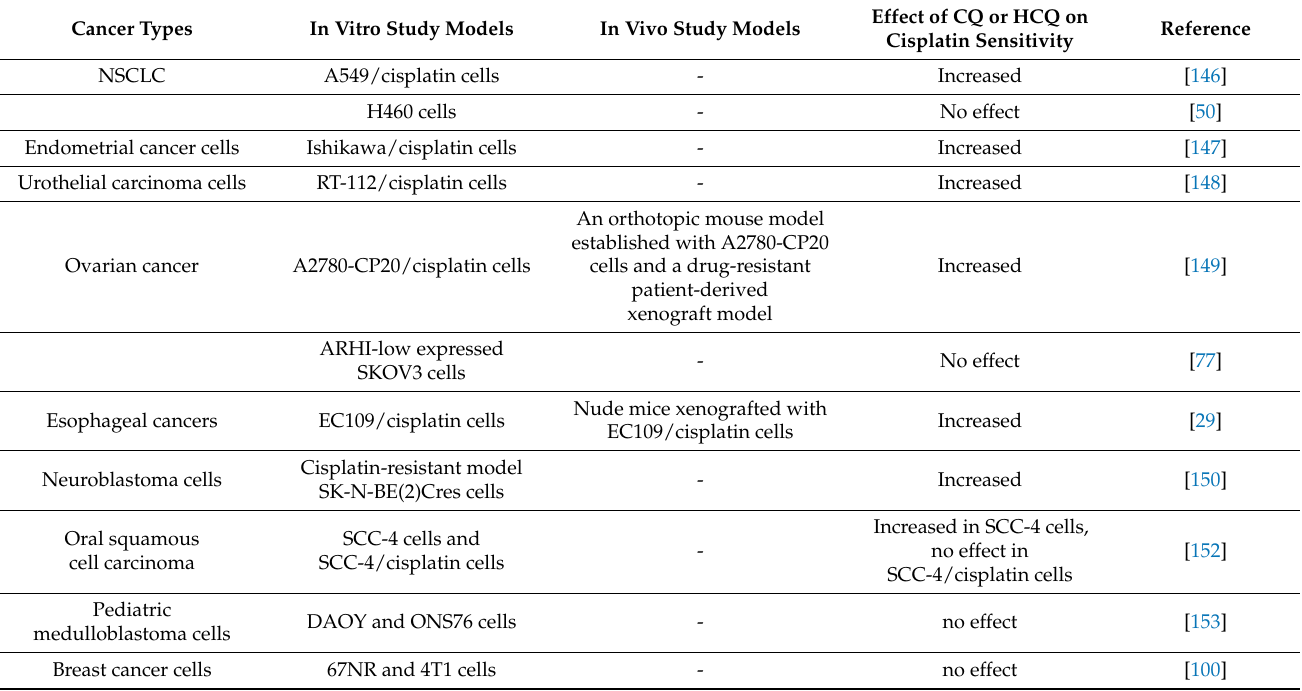
Table 1. Effect of CQ or HCQ on cisplatin-treated cancer